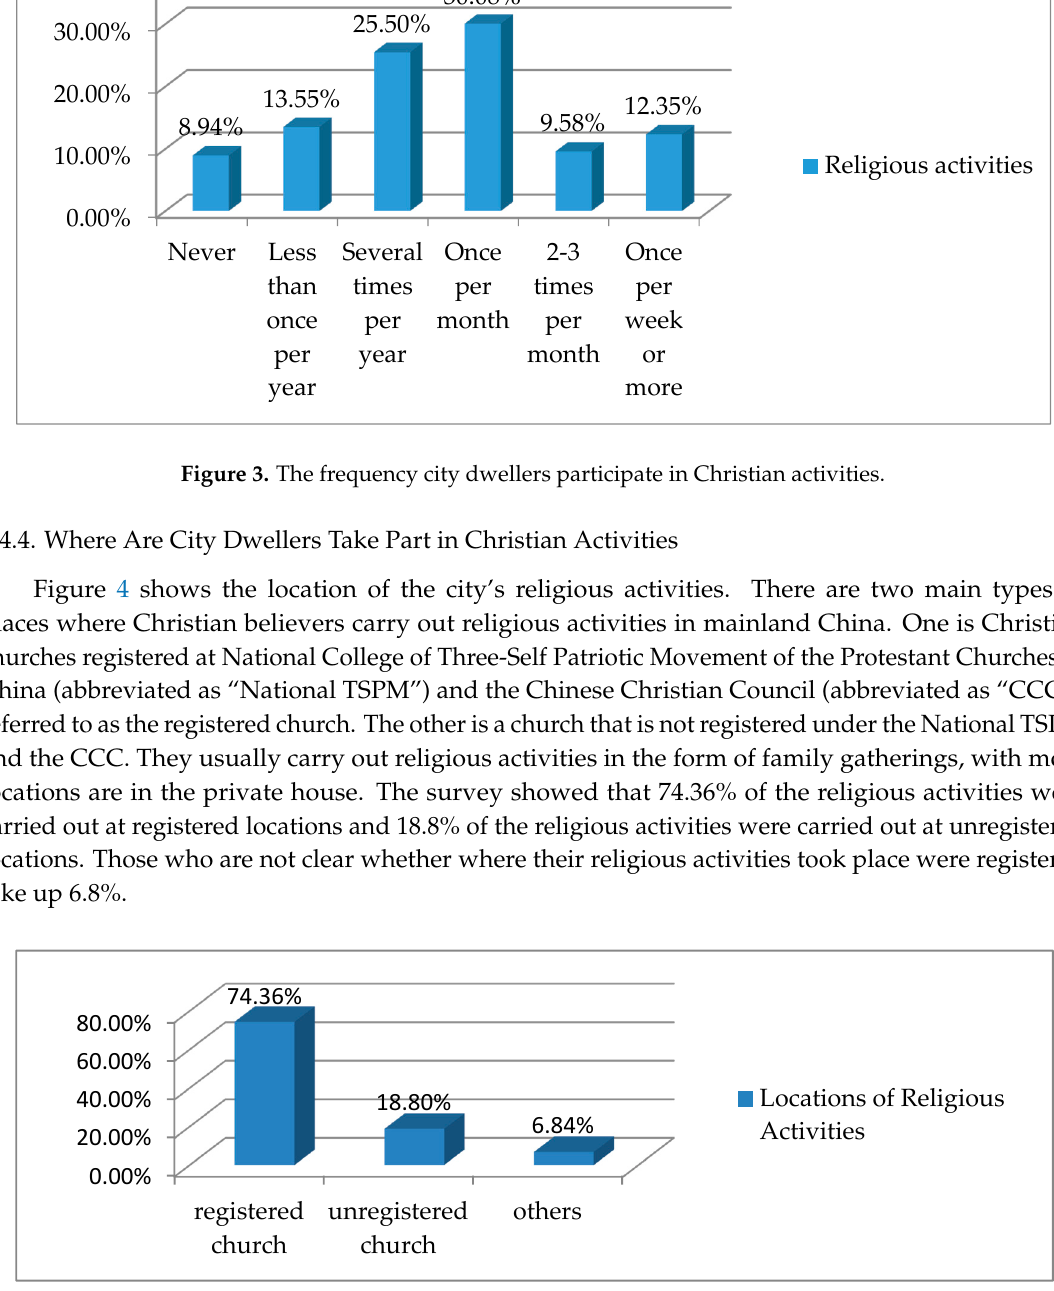
Figure 4. The locations city dwellers participate in Christian activities.